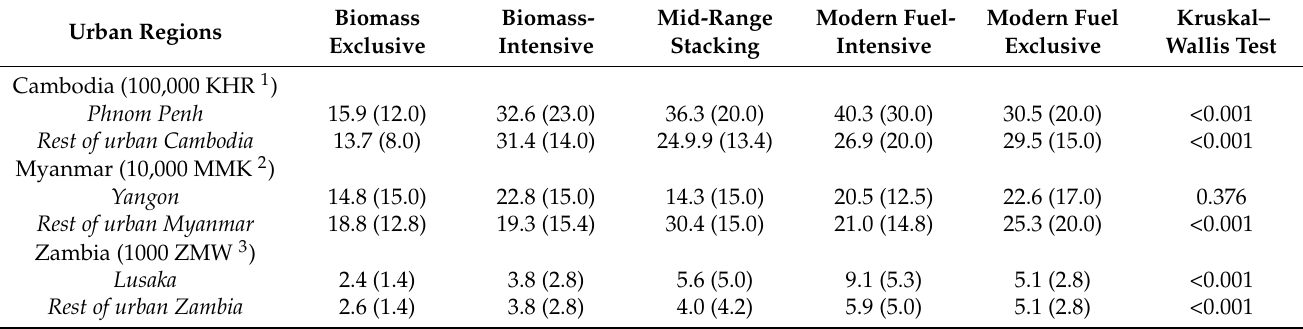
Table 5. Average monthly household incomes in local currency (mean